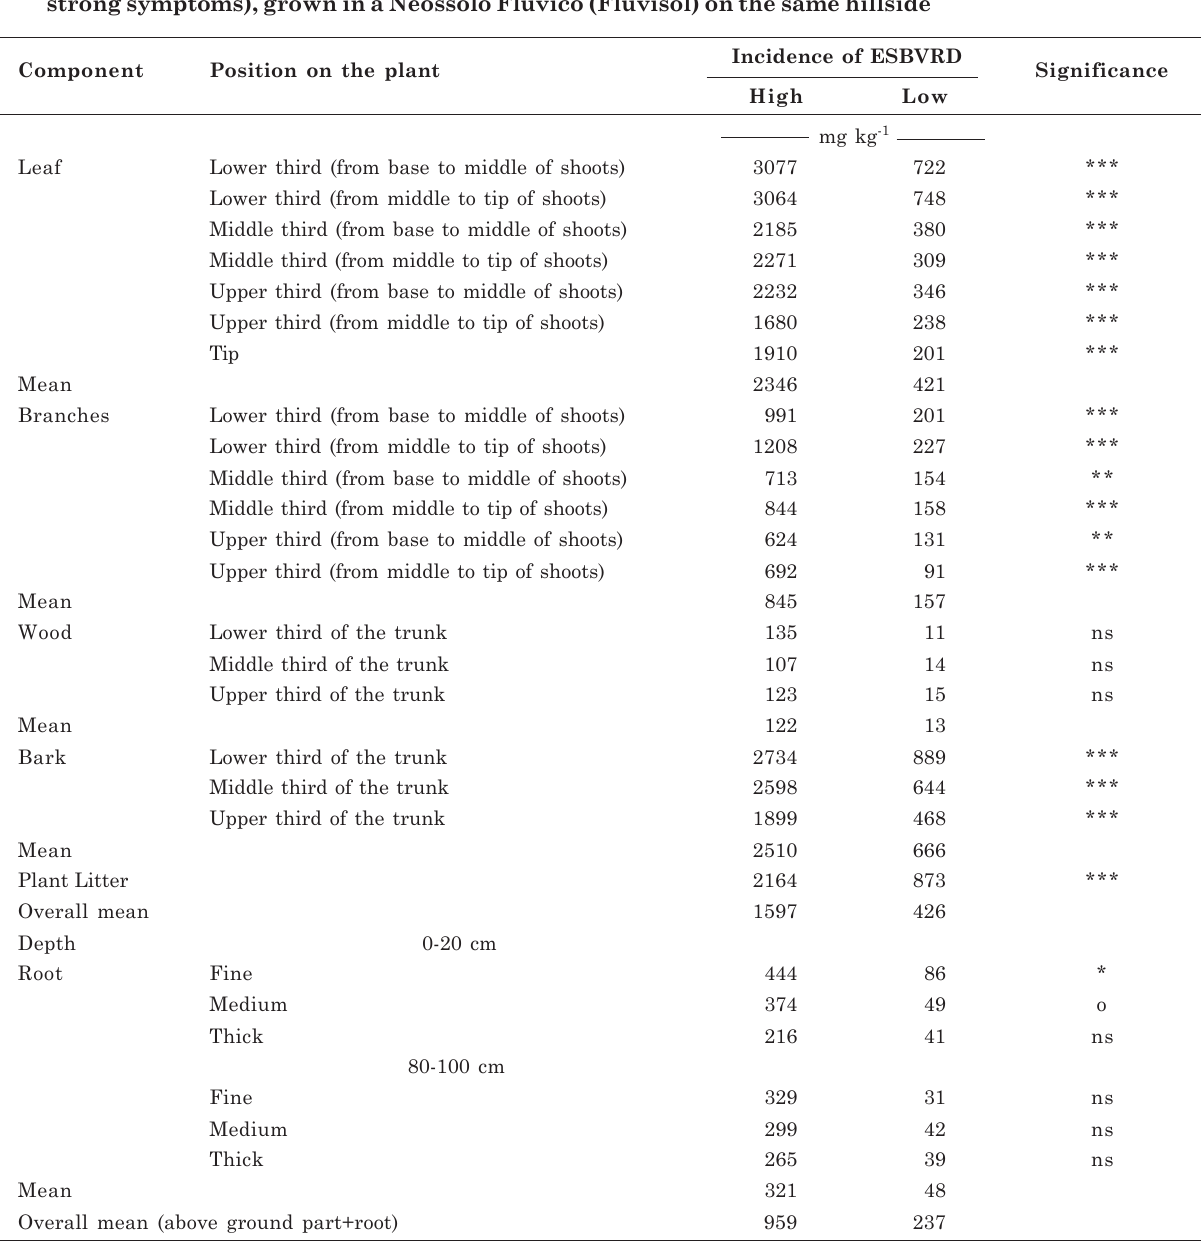
Table 6. Mn contents in components of the above ground part and roots in three diameter classes of eucalyptus plants (clone 386) under conditions of high and low incidence of ESBVRD, at a mutual distance of less than 150 m, in the region of Belo Oriente at 24 months of age (sampling carried out in July, phase of strong symptoms), grown in a Neossolo Flúvico (Fluvisol) on the same hillside